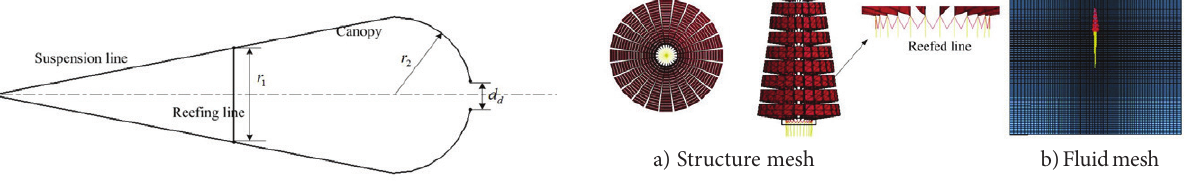
Figure 1. Aerodynamic shape of a reefed parachute